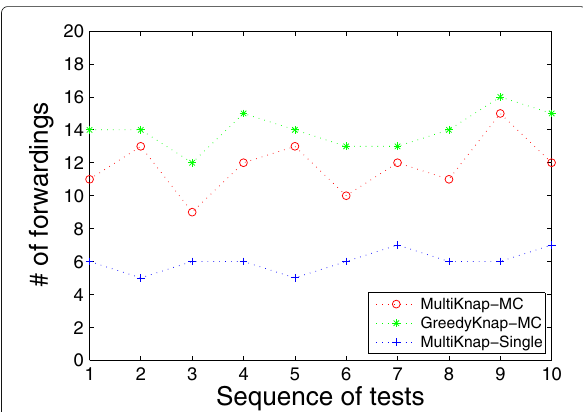
Fig. 8 Results of the number of